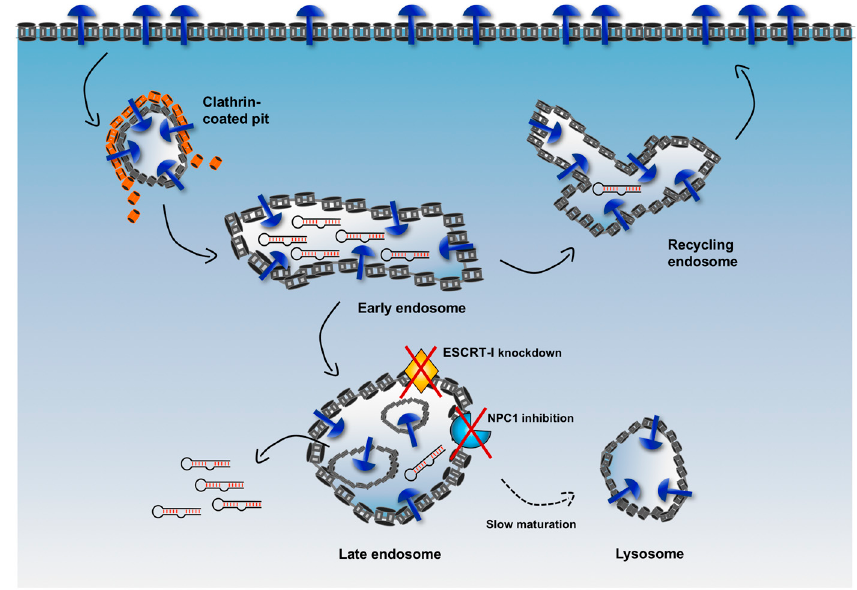
Figure 5. Schematic illustration of the expected vesicular trafficking of internalized aptamers and potential strategy to enhance endosomal escape. Upon binding to the target receptor, aptamers enter cells via clathrin-mediated endocytosis (or alternatively via caveolin-dependent uptake) and then are trafficked into early endosomes. In this compartment aptamers can also dissociate from the target receptor. Some receptors (such as transferrin receptor) can be recycled back to the surface, while other (like receptor tyrosine kinases, RTKs) are sorted to the endolysosomal compartment, which results in their downregulation by proteolysis. Internalized aptamers can follow a similar fate. They can be sorted back to the surface via recycling endosomes or into late endosomes. Some innovative strategies aim to delay endosomal maturation and extend the residence time of internalized molecules in non-recycling vesicles (for instance, targeting endosomal-associated proteins, such as ESCRT-I and NPC1). This can enhance the overall escape rate during each cycle of endocytosis.